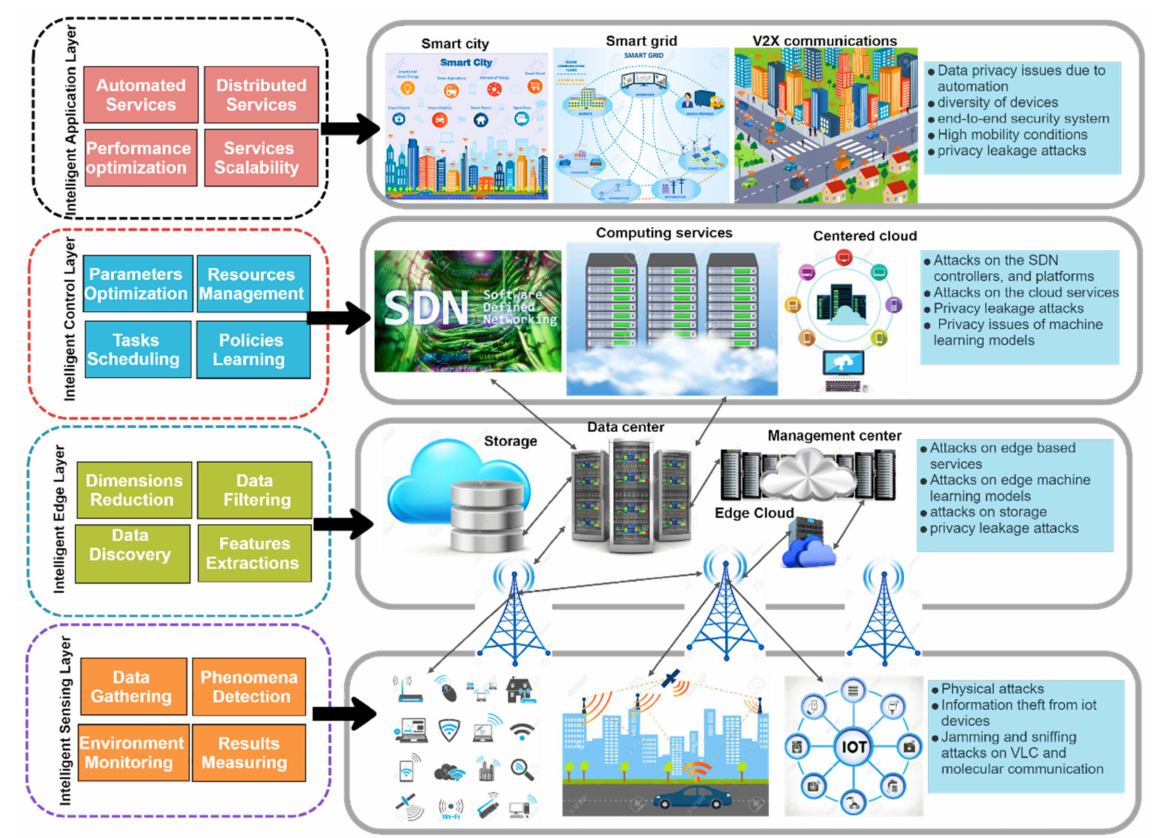
Figure 6. The 6G AI/ML security architecture, and different attacks in each